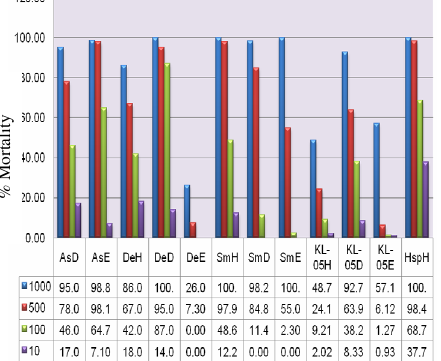
Figure 2. Percent mortality of brine shrimp larvae at 24-hours exposure to different concentrations (ppm) of the extracts of A. suberitoides , D.elegans , S. massa , KL-05 and Haliclona sp.